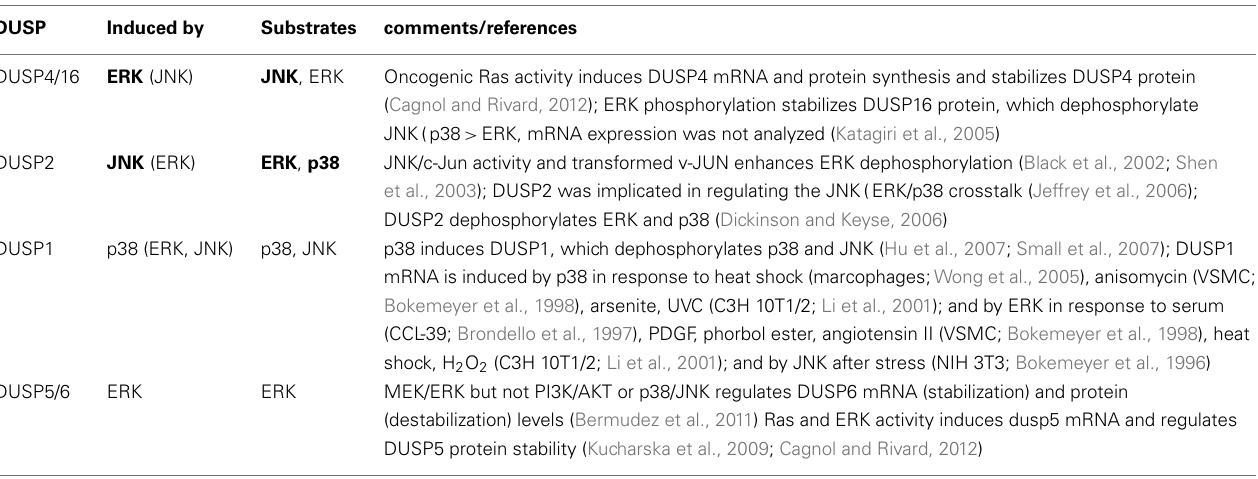
Table 3 | Inducible DUSPs implemented in the